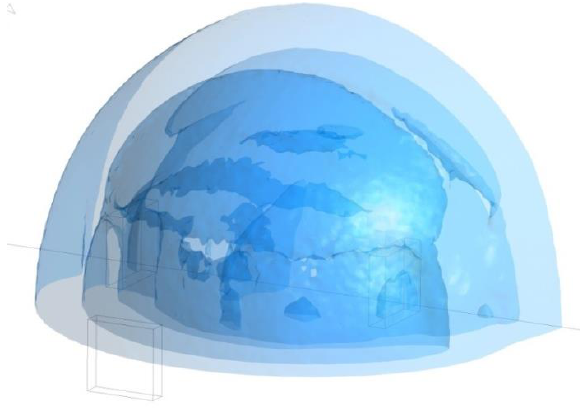
Figure 14. Display of an isobaric surface with a pressure of 2 kPa in a time of 15 ms.